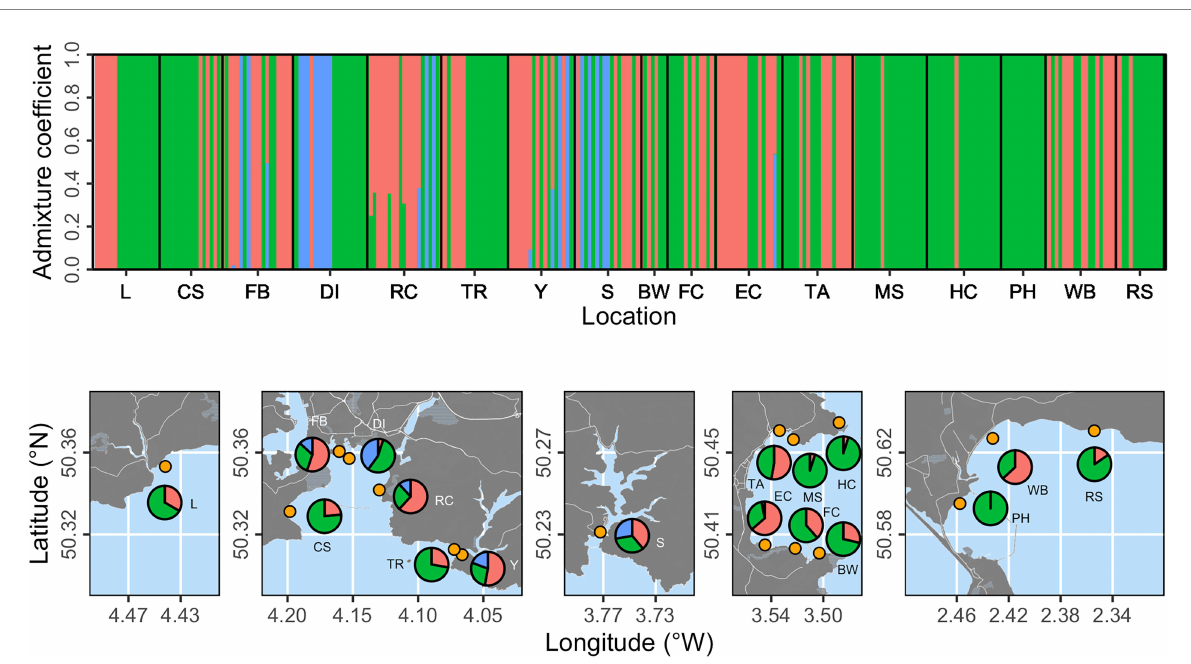
FIGURE 2 Population structure analysis based on three proposed genetic clusters. The top panel shows admixture coefficients indicating the probability of individual samples belonging to each of the three clusters (here shown as red, green, or blue). Bottom panels show location level summaries of admixture coefficients at each of the 17 sampling locations (orange